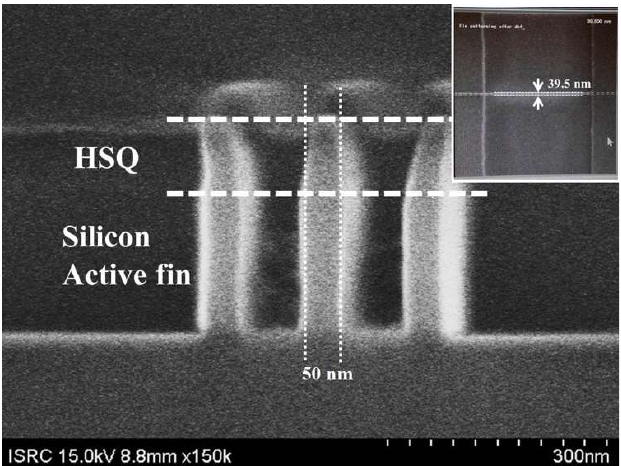
Figure 4. Cross-sectional view of scanning electron microscope (SEM) image which demonstrates Si fin etching. The inset shows top view of SEM image after fin etching and SC-1 reduction processes. Micromachines 2019 , 10 , x FOR PEER REVIEW